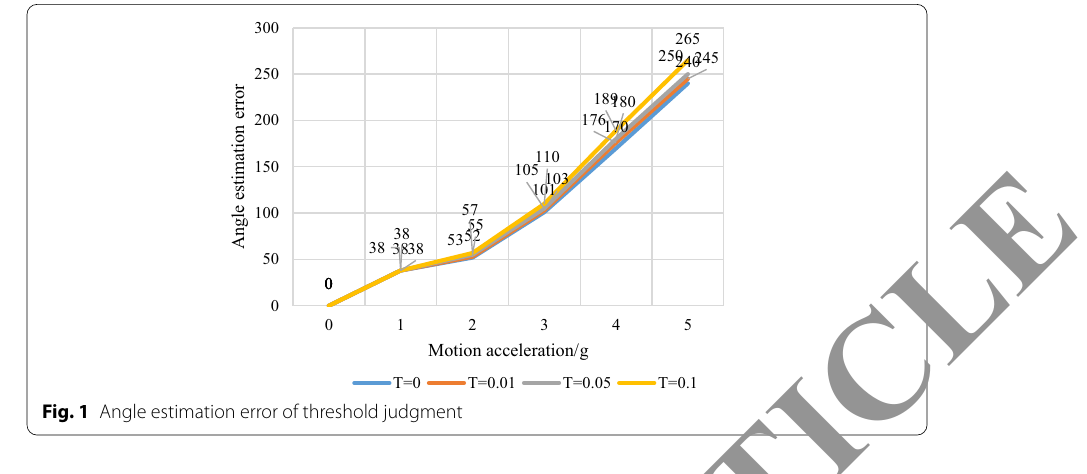
Fig. 2 Block diagram of the inertial motion capture